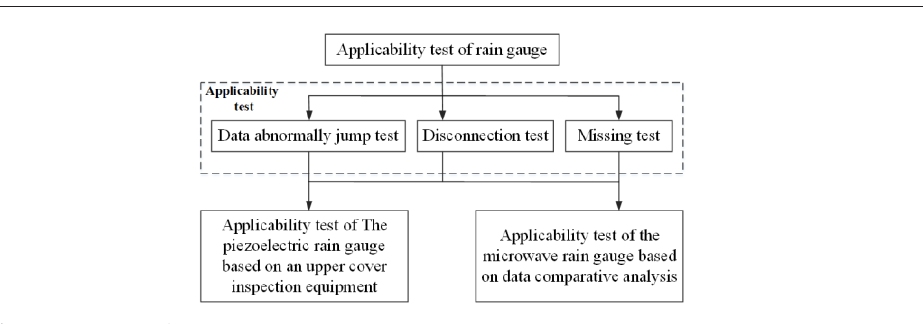
Fig. 2. Flow chart of the rain gauges applicability test